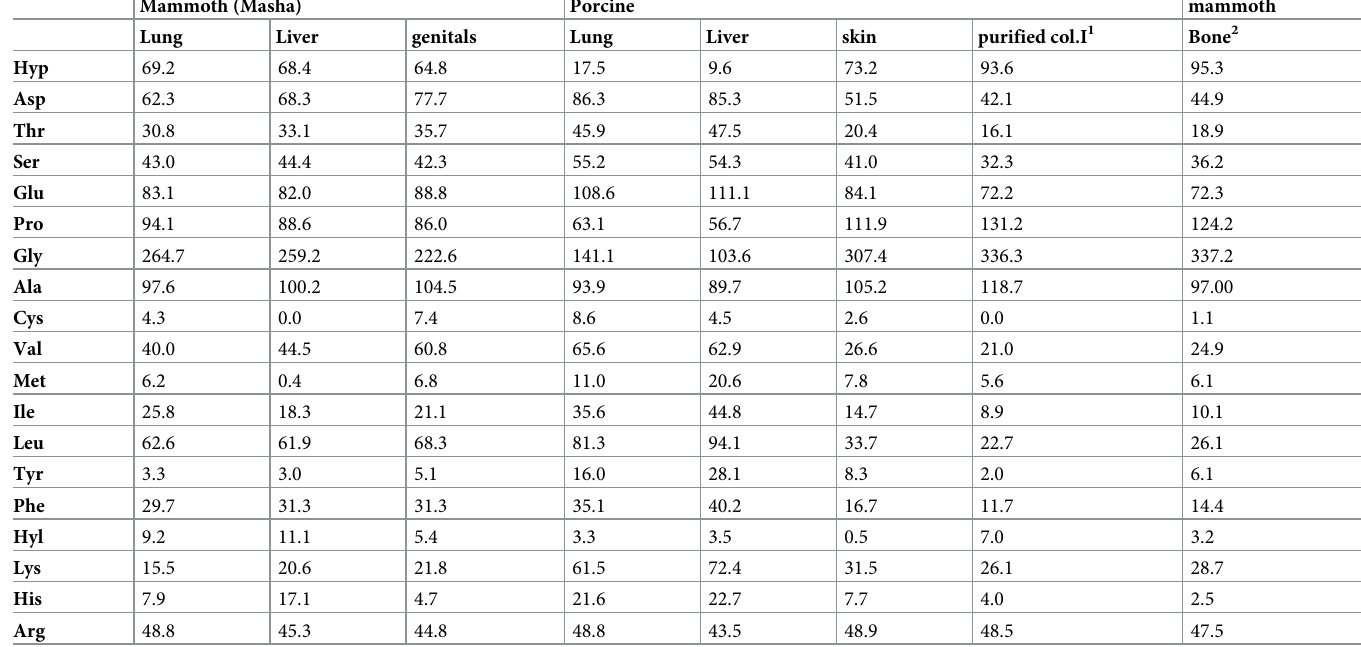
Table 1. Amino acid content (Residues/1000 residues) of mammoth (Masha) lung and liver, bovine lung, and porcine liver and skin. Representative data out of three or four analyses. Mammoth